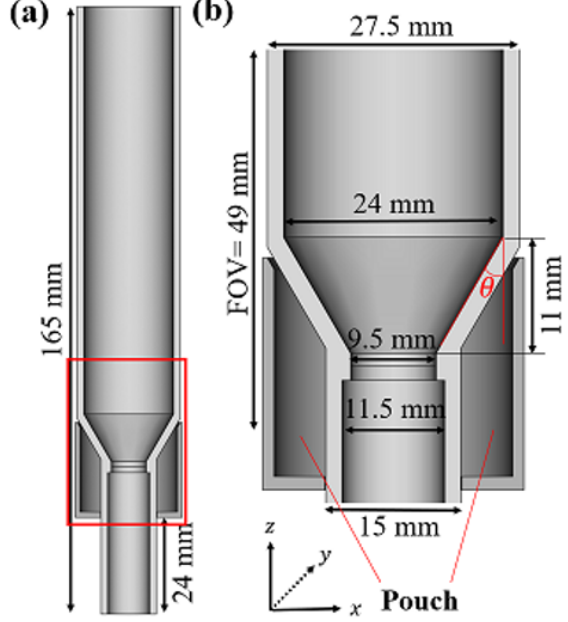
Fig. 1. (a) The schematic design of the 30° hopper. (b) A close-up of the imaged part of the hopper.